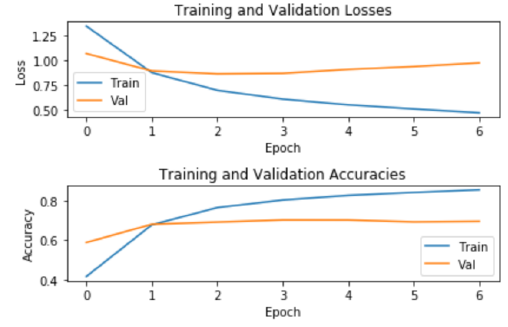
Figure 10. MLP—loss and accuracy convergence.